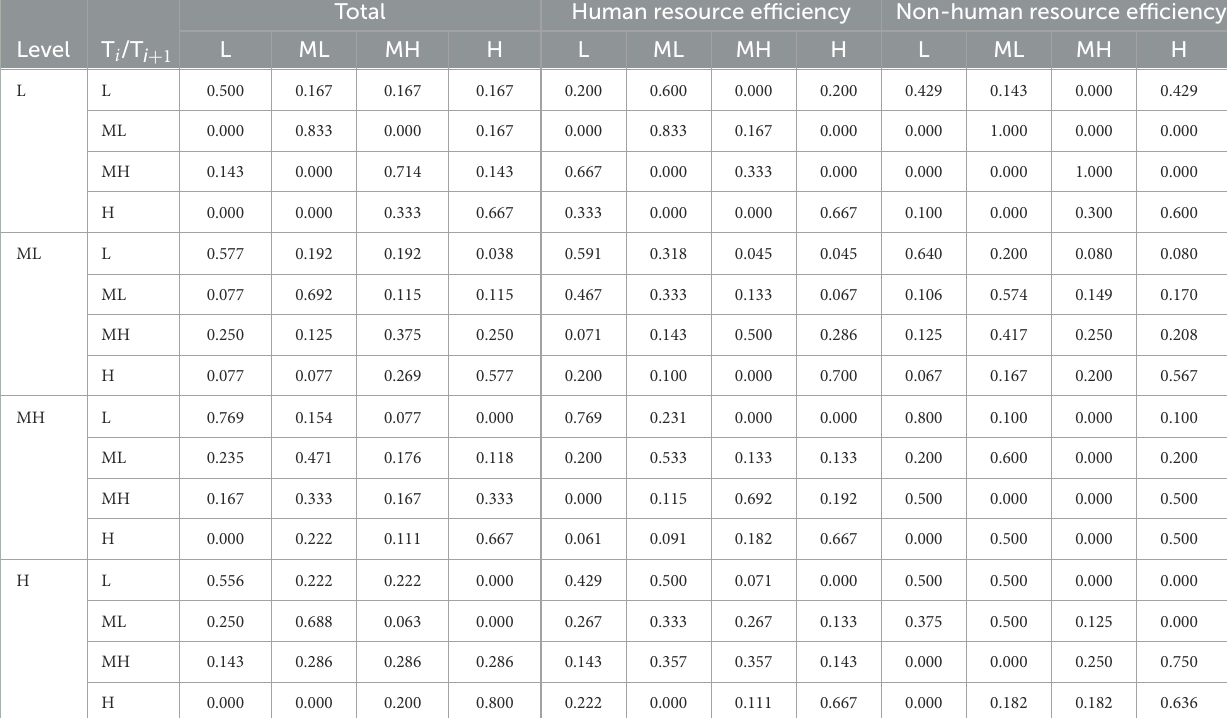
TABLE 4 Spatial Markov